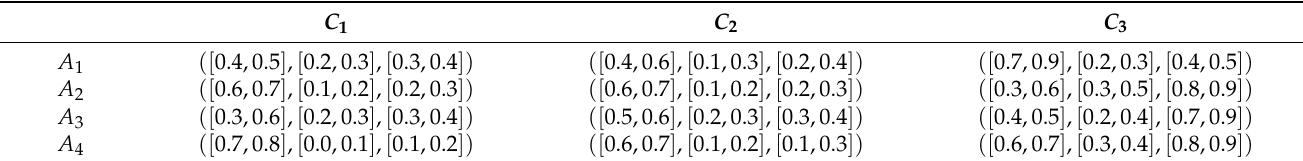
Table 3. The evaluation of